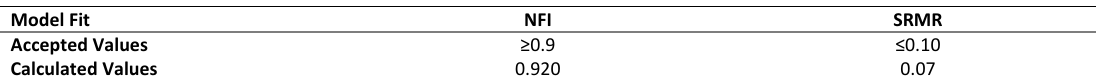
Table3: Fit Indexes